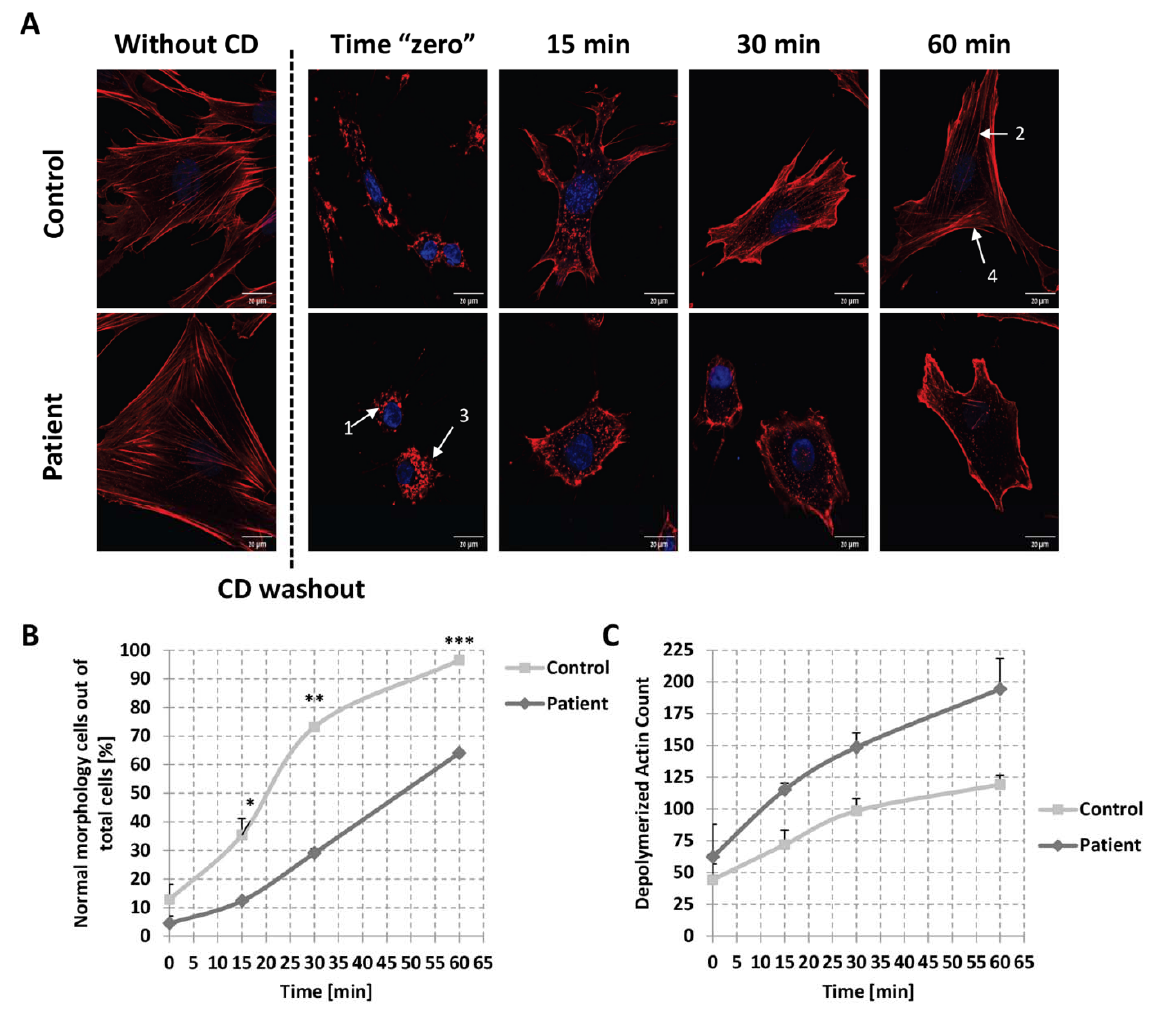
Figure 4. Effect of changing Arg 511 to His on the kinetics of the repolymerization of actin and cell morphology in patient and control fibroblasts. ( A ) The recovery of actin filaments in control and patient fibroblasts after disruption with cytochalasin D (CD) and at various time points after removing the drug was visualized by confocal microscopy using fluorescent phalloidin. The arrows indicate (1) completely disassembled actin; (2) repolymerized actin; (3) round cell morphology, which may represent detachment from the plate; and (4) normal cellular morphology. ( B , C ) Quantification of the depolymerized actin filaments and the cell morphology, respectively. Results represent n = 6 from three independent cultures. Error bars are SD. * p ≤ 0.005, ** p ≤ 0.001, *** p ≤ 0.0005.